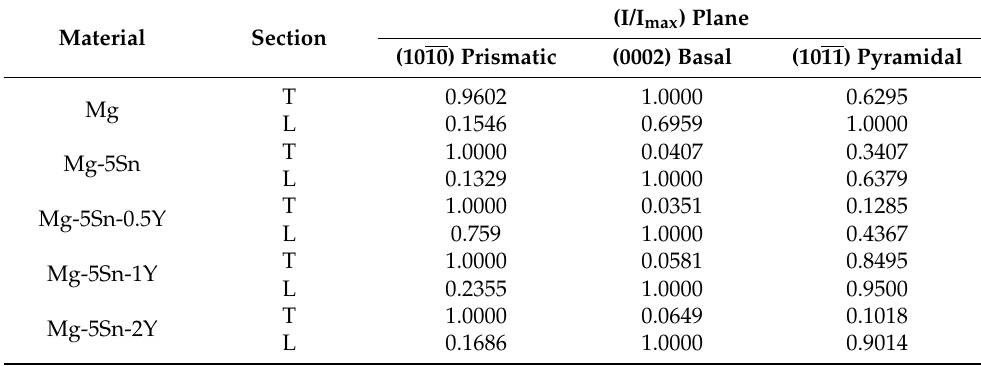
Table 1. X-ray diffractogram intensities (T-Transverse and L-Longitudinal).